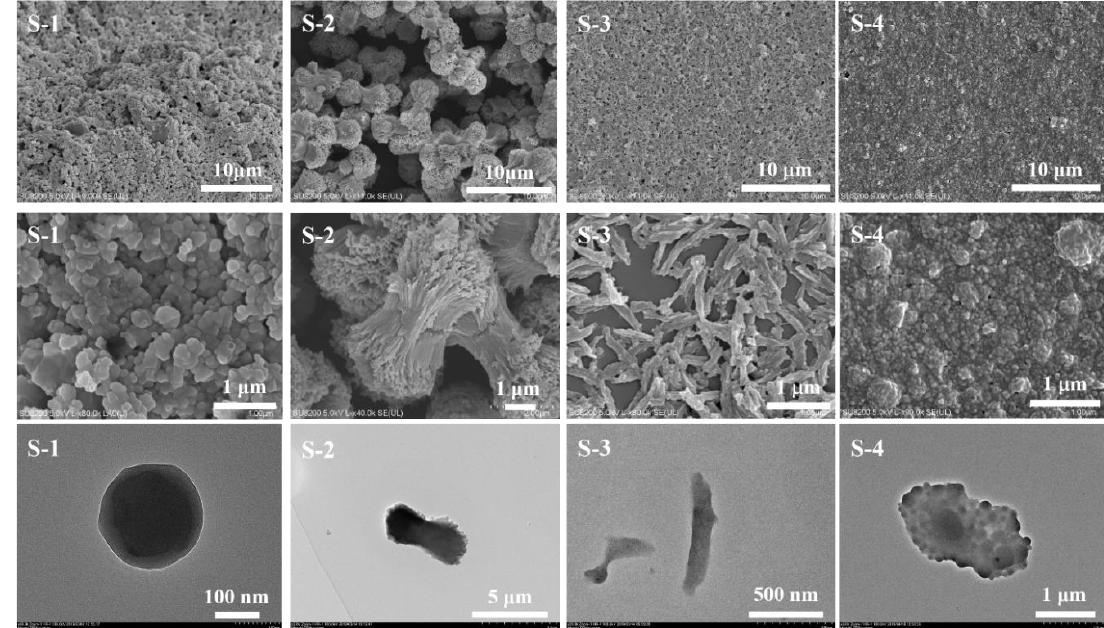
Figure 6. The first and second rows: SEM images of surfaces cast from the i PP / a PS miktoarm star copolymer solutions; the bottom row: TEM images of the i PP / a PS miktoarm star copolymers drop-cast from the DMF solution.